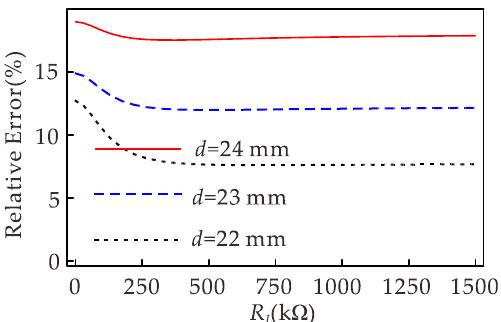
Figure 7. The relative error of the RMS power versus the load resistance when the torque is not considered.